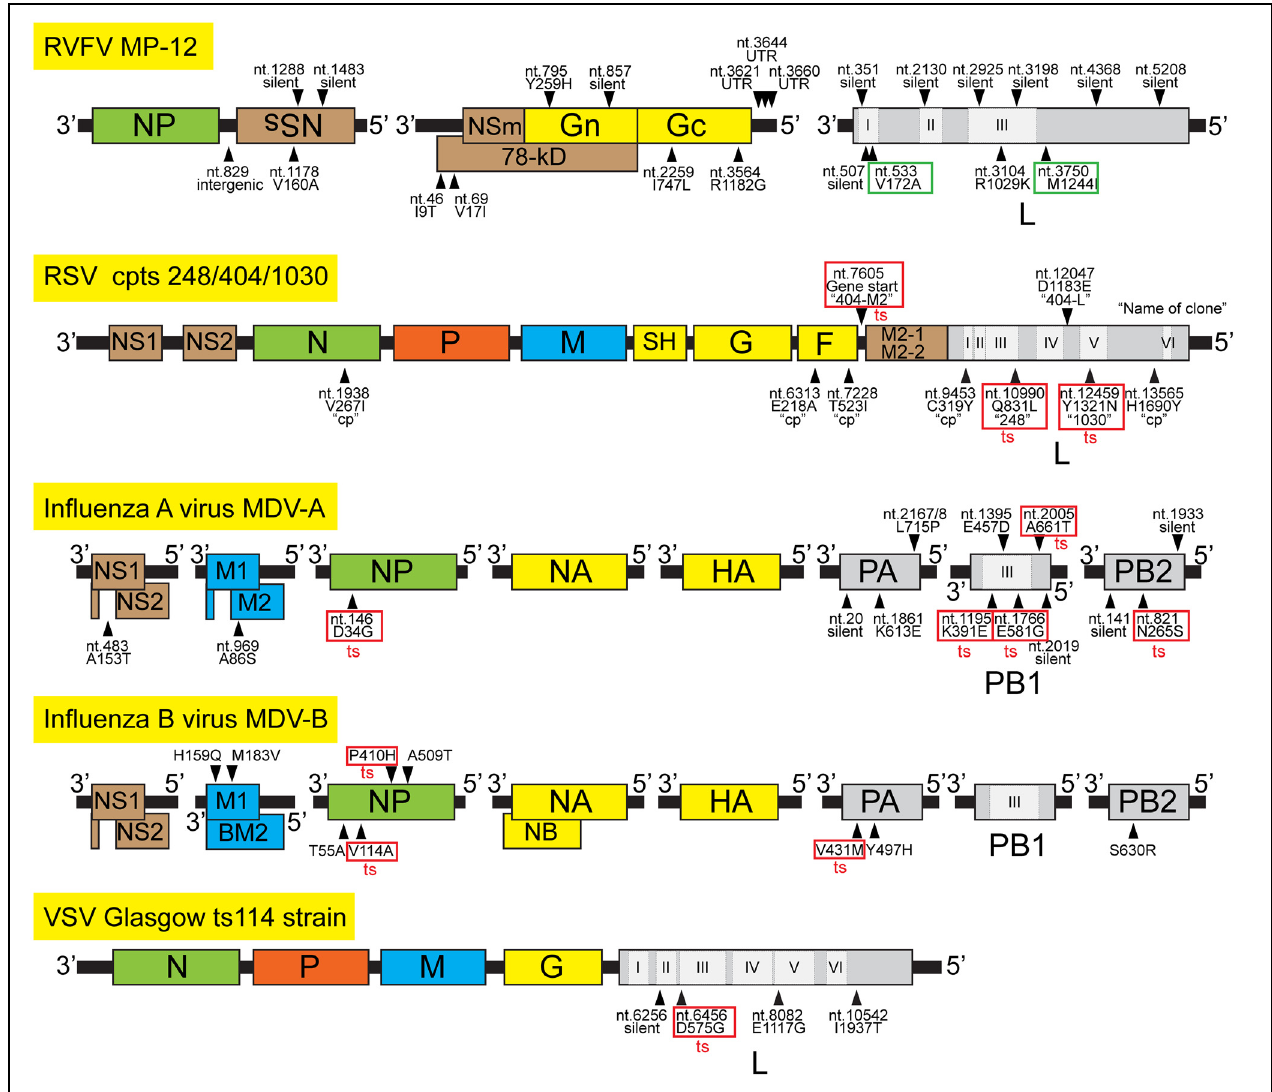
FIGURE 1 | Mapping of temperature-sensitive (ts) mutations for selected negative-stranded RNA viruses. The genome structures of RVFV MP-12 strain, Respiratory syncytial virus (RSV) cpts 248/404/1030, Influenza A virus (MDV-A), Influenza B virus (MDV-B), and Vesicular stomatitis virus (VSV) ts114 strain are shown. Viral genes are shown in different colors: Nucleocapsid protein (green), phosphoprotein (orange), RNA-dependent RNA polymerase (gray), envelope protein (yellow), matrix proteins (blue), and accessory or non-structural